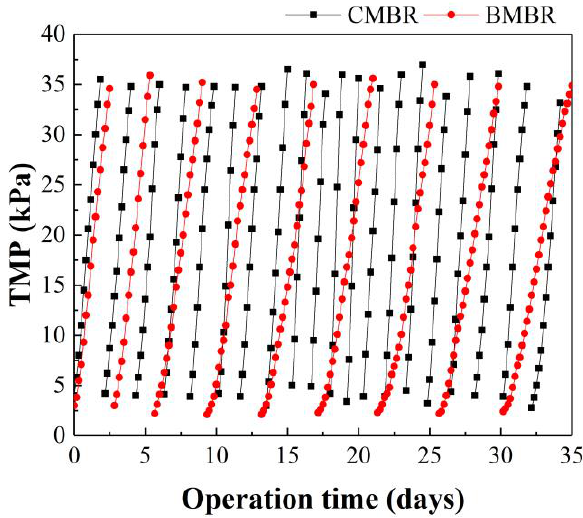
Figure 5. TMP profiles of the conventional MBR (CMBR) and biochar MBR(BMBR).